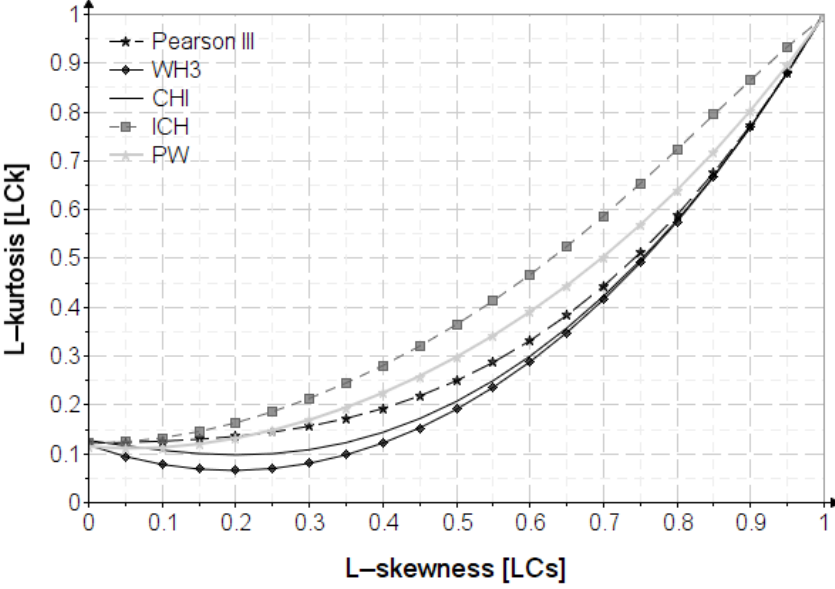
Figure A1. The variation diagram of LC s − LC k .